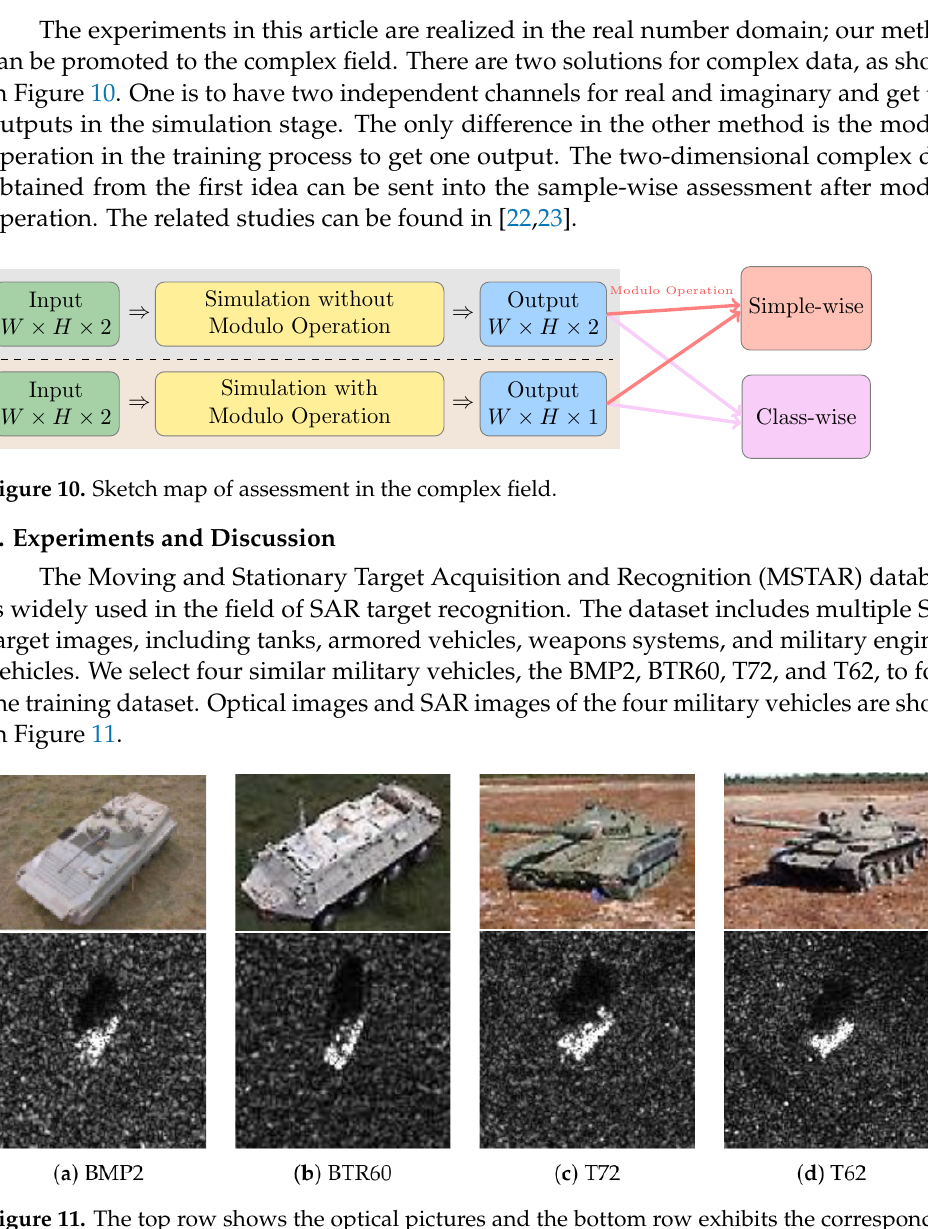
Figure 9. Hybrid training sets with the same total number. The blue part indicates real images and the red part indicates simulated images.